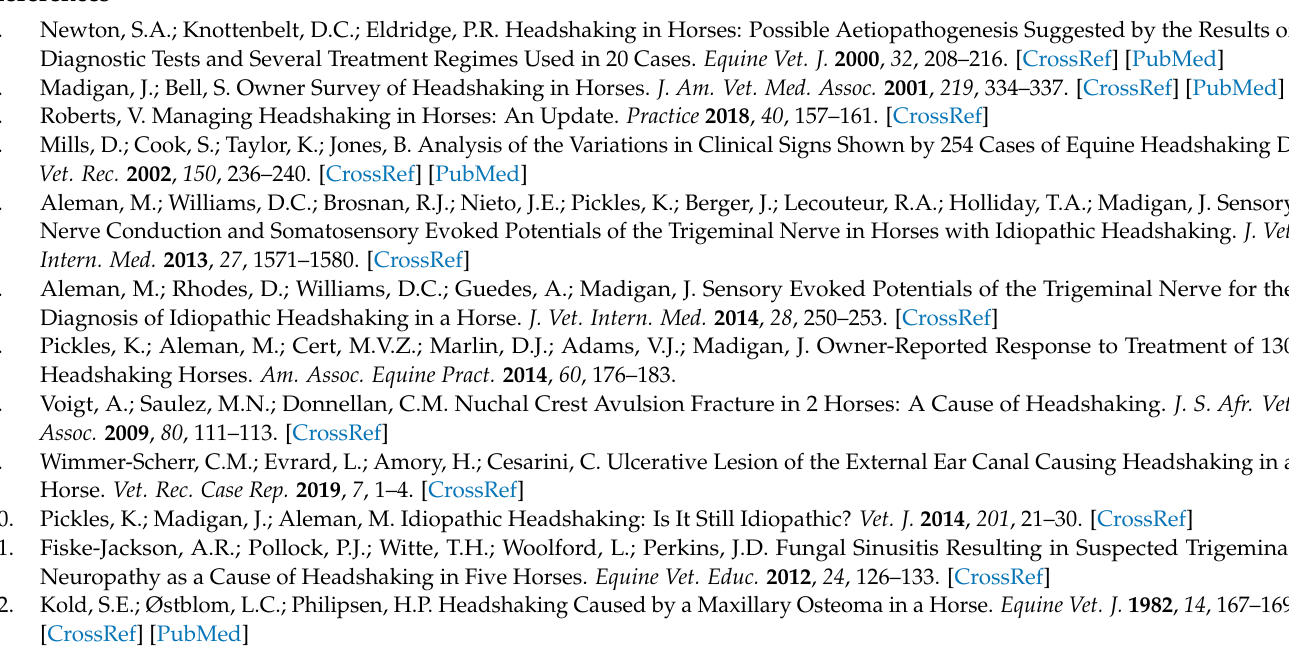
score; Table S3: Overview of findings within the diagnostic investigation of horses with headshaking; Table S4: Results of laboratory analysis; Table S5: Summary of conducted statistical data